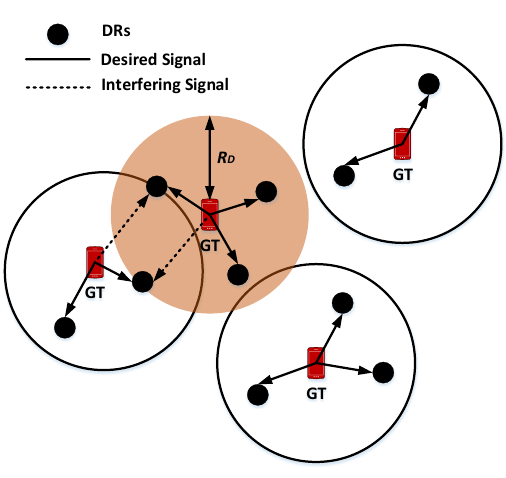
Figure 1. Example of inband non-orthogonal multiple access (NOMA) group device-to-device (D2D) communications with overlay cellular